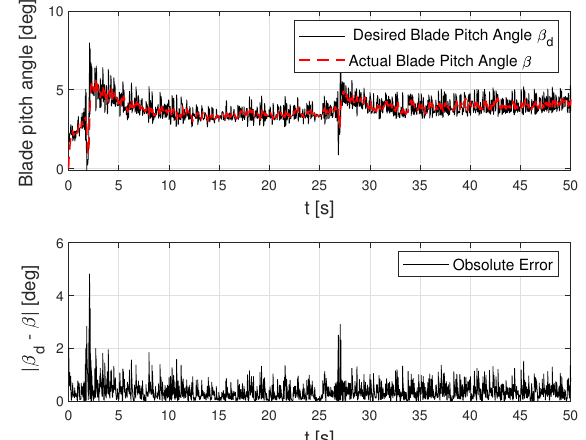
Figure 11. Absolute error of the desired and actual blade pitch